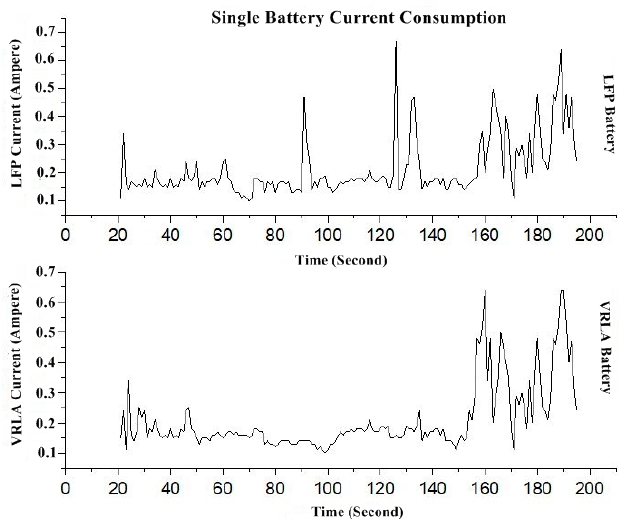
Figure 16. Single battery current consumption of VRLA and LFP graph.